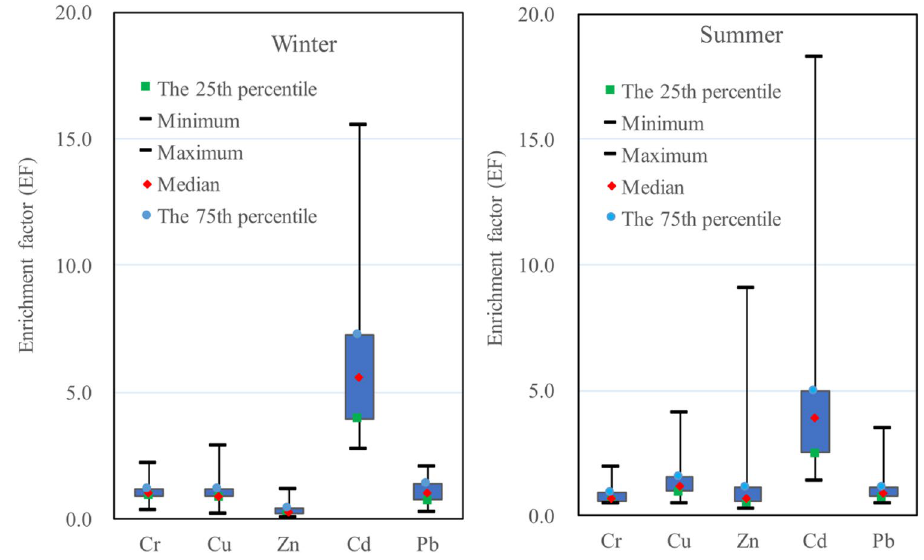
Fig. 2 Enrichment factor of Cd, Cu, Cr, Pb and Zn in the surface